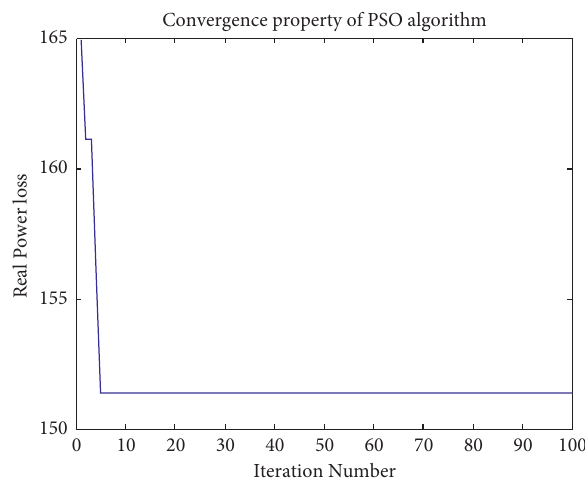
Figure 5: Convergence property of PSO